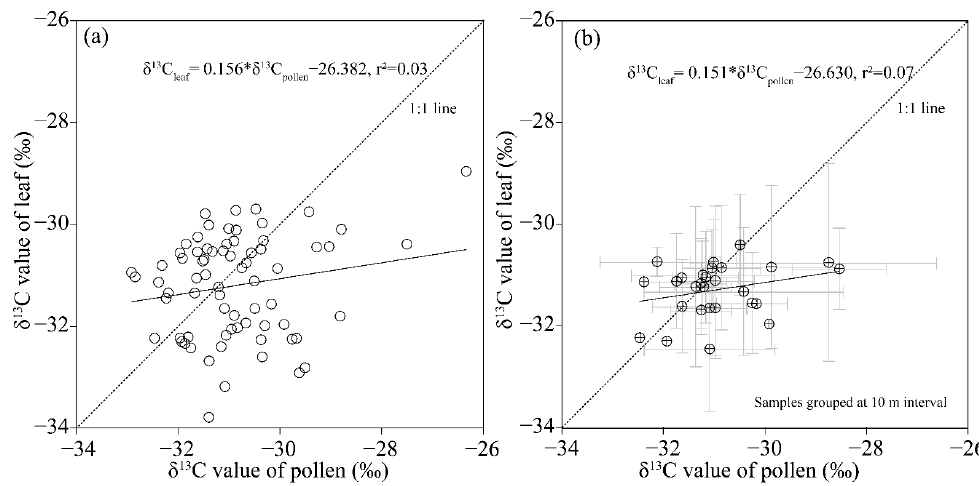
Figure 3. The relationship between the δ 13 C value of pollen and leaf from Pinus yunnanensis on the south bank of Lugu Lake in northwestern Yunnan, China. ( a ) samples with original data; ( b ) samples grouped at 10 m interval of altitude with their means and one standard deviation. Along an elevation gradient from ca. 2700 to 3100 m, a distinct difference occurred between the pollen and leaf δ 13 C values of Pinus yunnanensis (Figure 4a,b). A negative